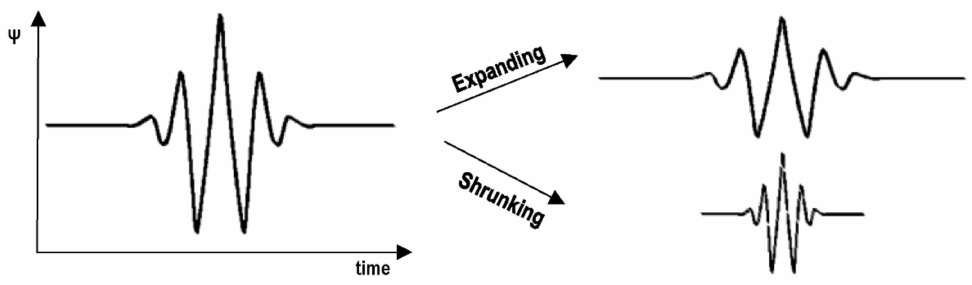
Figure 5. Types of dilation of the mother wavelet